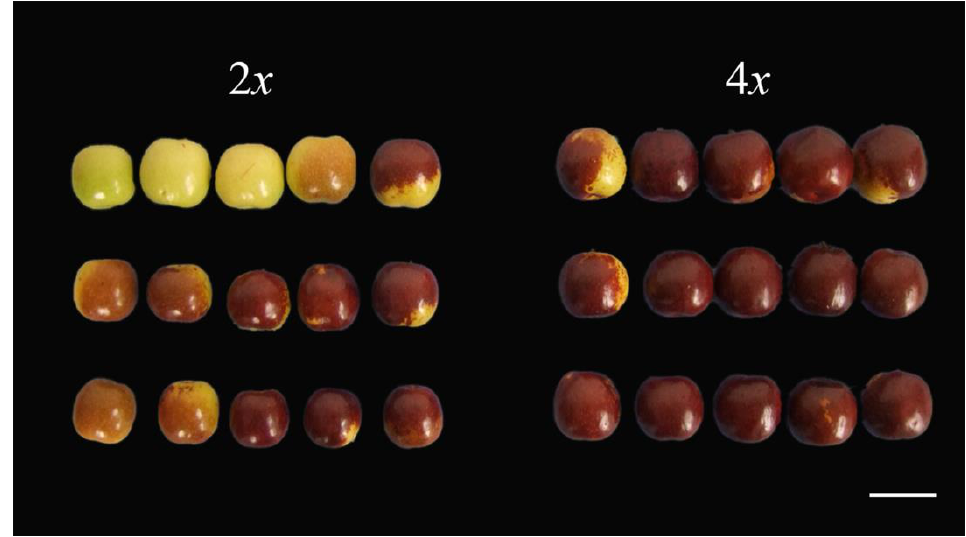
Figure 8. Fruit morphology of ‘Xingtai 060 4 ′ (2 x ) and ‘Zhuguang’ (4 x ), bar = 30 mm. Table 4. Fruit characteristics and quality of ‘Xingtai 0604 (cid:48) and ‘Zhuguang’. Fruit